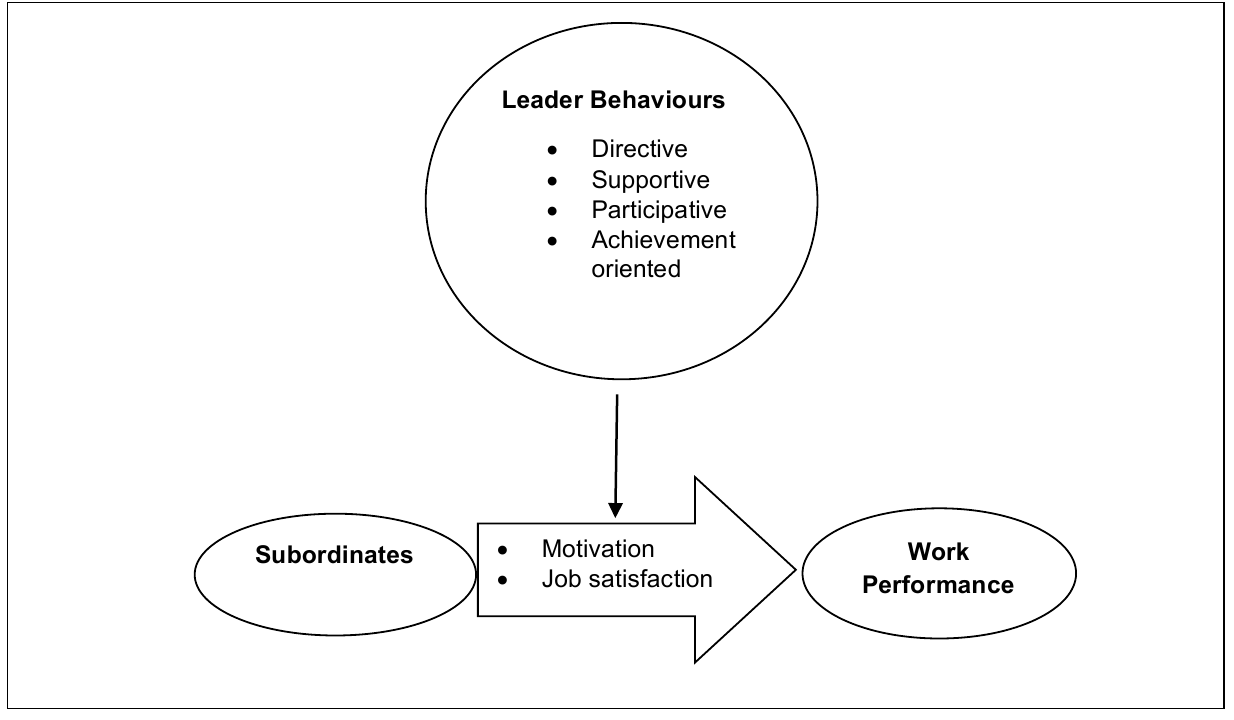
Figure 1: Effect of Leader Behaviours on Subordinates’ Work